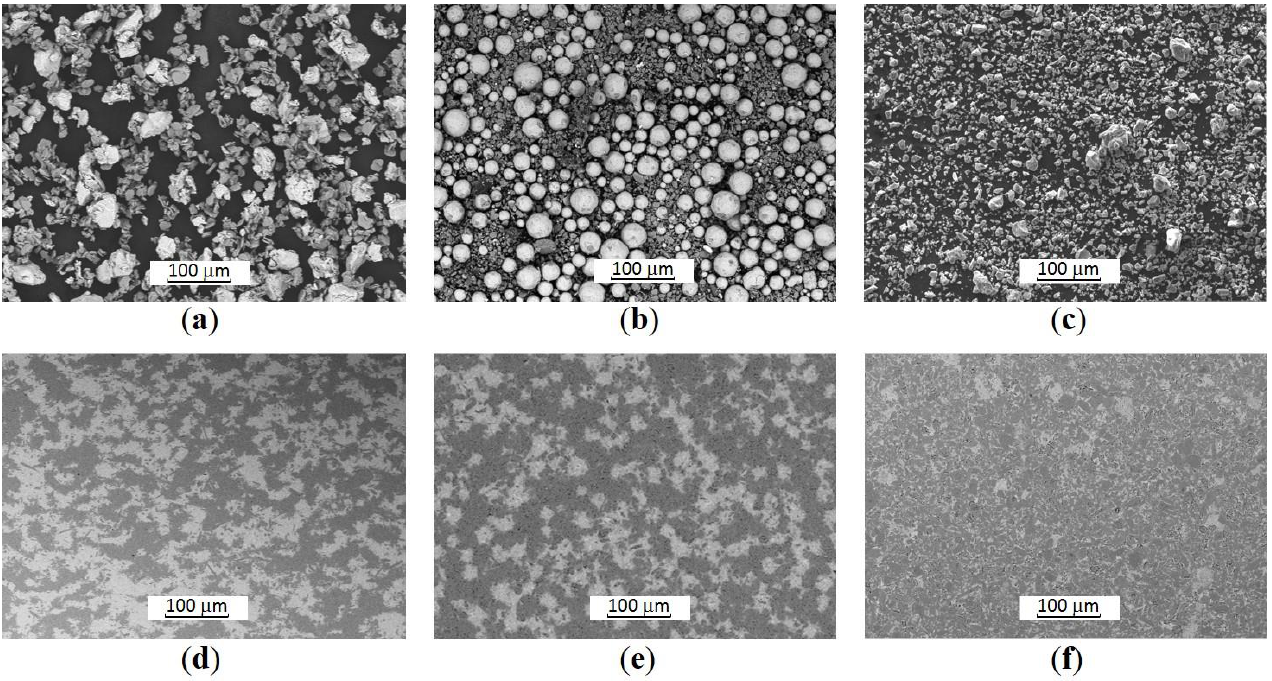
Figure 1. SEM images of the powders mixtures: ( a ) Group I (Ti-TiB 2 ); ( b ) Group II (Ti6Al4V-TiB 2 ); ( c ) Group III (Ti-B after SHS and subsequent disintegrator milling). SEM images of the SPS-ed samples: ( d ) Group I (at 50 MPa, 1250 °C, 15 min); ( e ) Group II (at 50 MPa, 1250 °C, 15 min); ( f ) Group III (at 50 MPa, 1350 °C, 15 min).